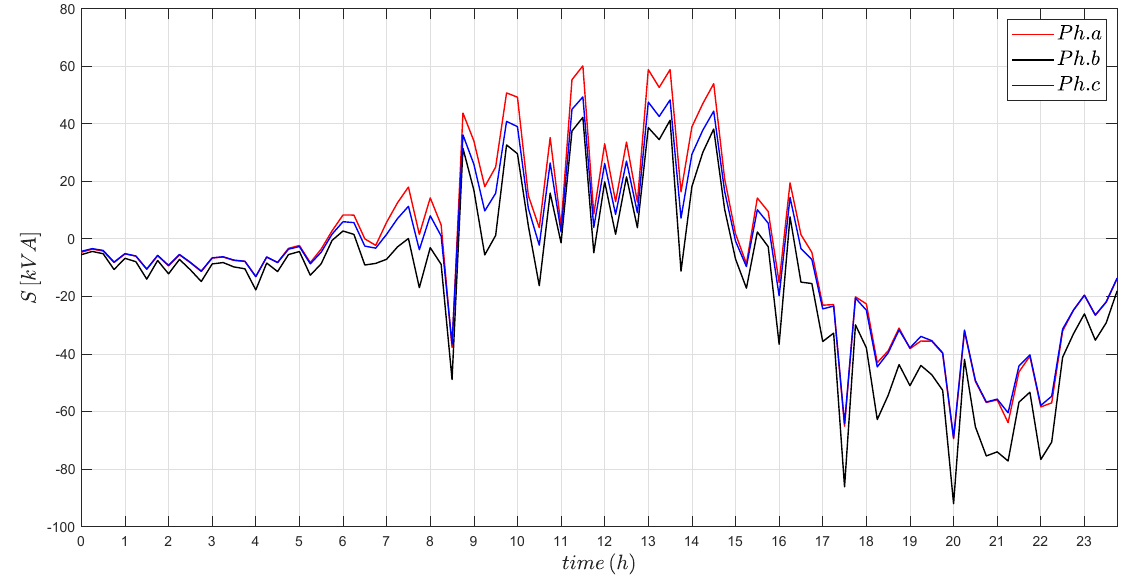
Figure 11. Net total apparent power at the MV/LV transformer without considering